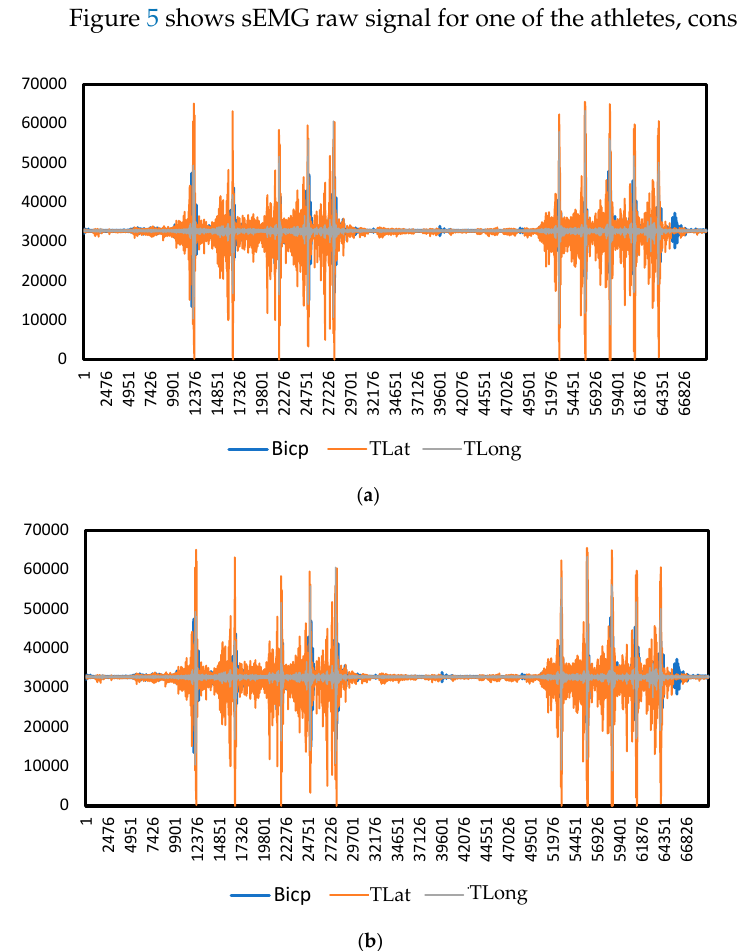
. Figure 6. Average of the normalized intermuscular amplitude (%MVC) and their standard deviation. Statistically significant values are highlighted in the figure with an asterisk. Figure 7 shows the average values of the activation time and the respective standard deviation for both of the rackets.